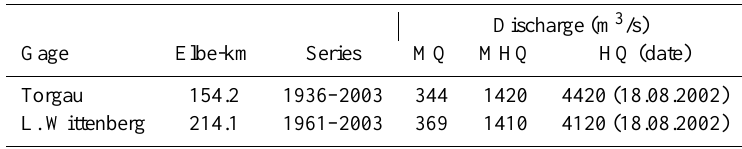
Table 1. Discharge statistics for the gages at Torgau and Lutherstadt Wittenberg (MQ – mean discharge, MHQ – mean maximum annual flood, HQ – highest recorded flood event); source: Gew¨asserk¨undliches Jahrbuch, Elbegebiet Teil 1, 2003. Note the lower discharge recorded at Lutherstadt Wittenberg than Torgau due to water retention in the flood plains between Pretzsch and Lutherstadt Wittenberg (see Fig. 2) and three dyke breaches between Torgau and Pretzsch.